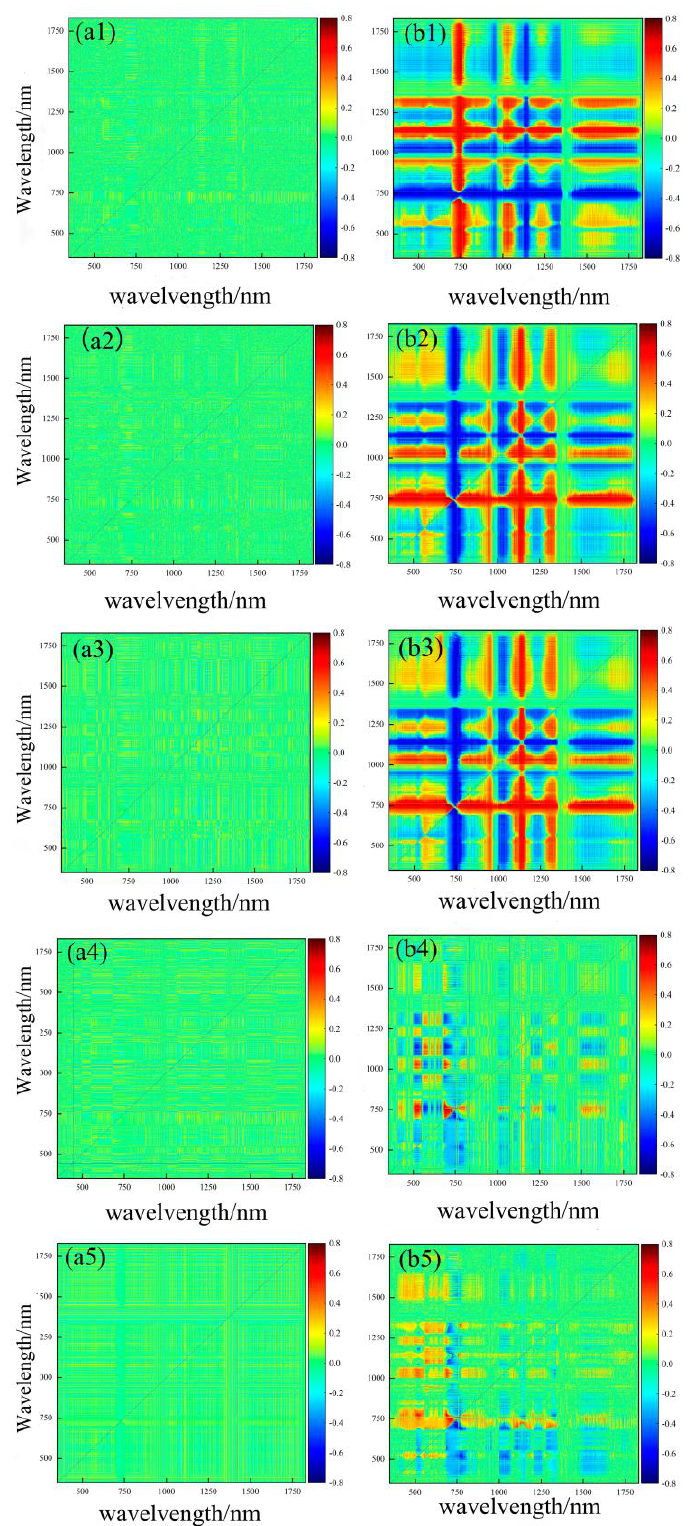
Figure 4. Correlation matrix diagram of spectral index and soybean chlorophyll content at different growth stages (( a1 – a5 ): V4 growth period mNDI, NDVI, RI, mSR and SAVI and soybean chlorophyll content correlation matrix; ( b1 – b5 ): R2 growth period TVI, DI, SAVI, RI, and NDVI and soybean chlorophyll content correlation matrix).